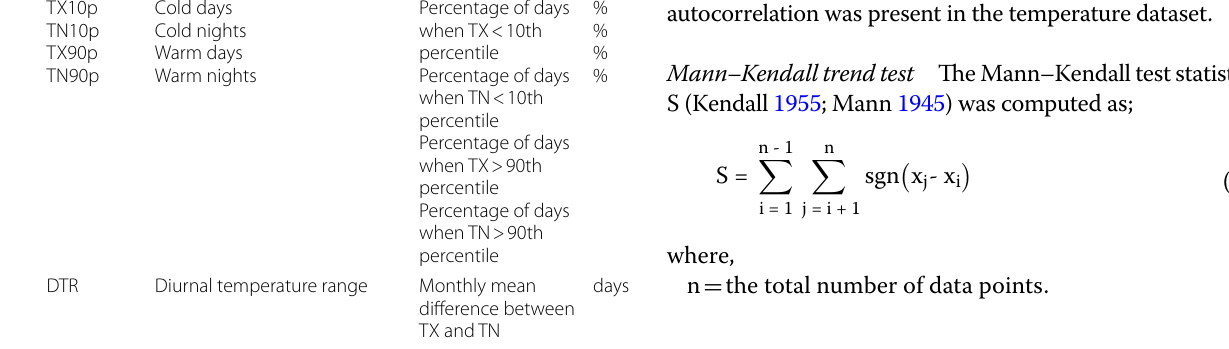
Diurnal temperature